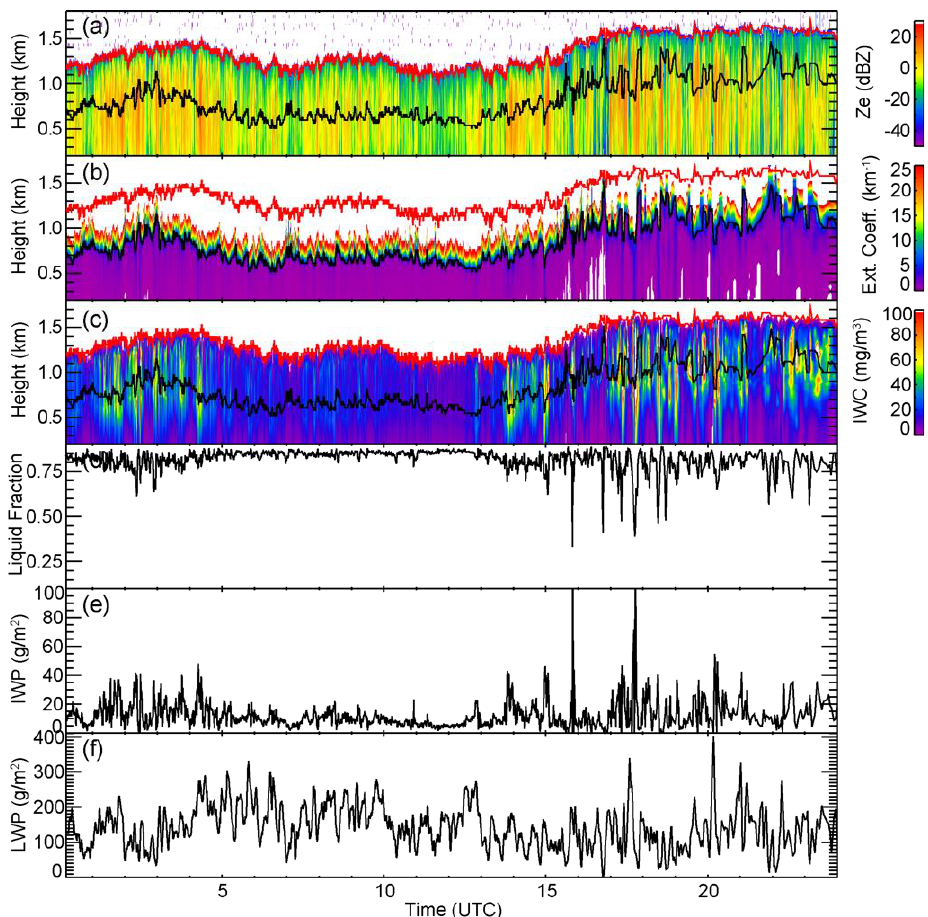
Figure 1. Examples of Arctic stratiform mixed-phase clouds sampled over the NSA site on October 10, 2004, including ( a ) MMCR Ze, ( b ) MPL extinction coefficient, ( c ) retrieved IWC, ( d ) liquid fraction, ( e ) IWP, and ( f ) LWP. The black and red lines in (a-c) represent the cloud base and the cloud top.